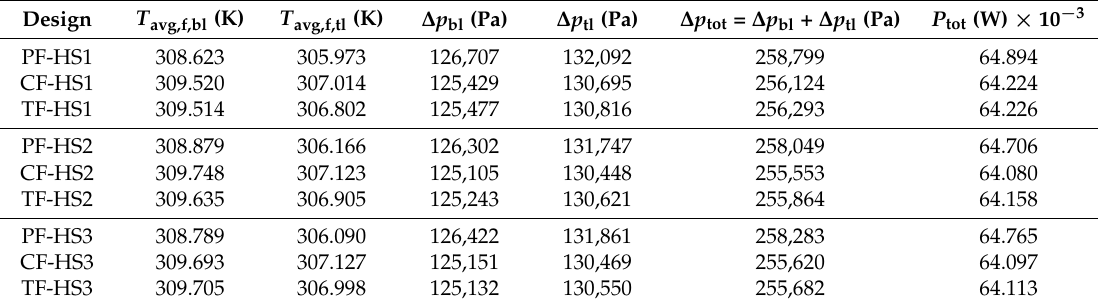
Table 11. Average fluid temperatures (in each layer) and pressure drops (in each layer and total) of the PF, CF, and TF heat sinks with the hotspot schemes HS1, HS2, and HS3 at the total flow rate of 0.01